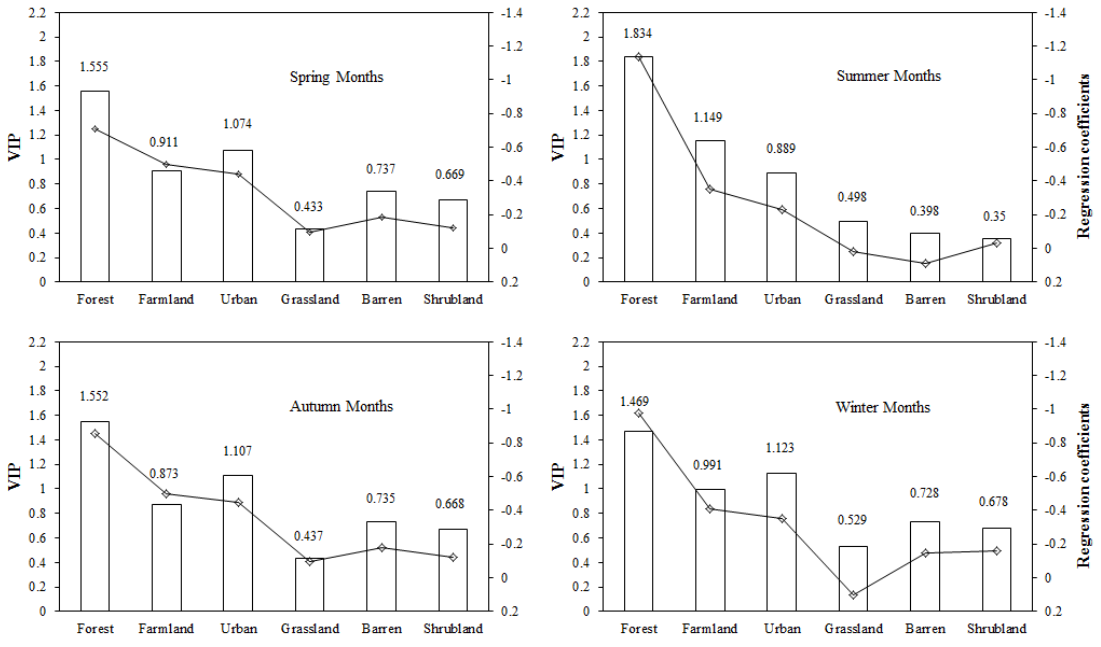
Figure 7. Regression coefficients (lines) and the Variable Influence on Projection (VIP) (bars) of each land use type. Table 6. Summary of partial least-squares (PLS) regression models of baseflow for all sub-watersheds. Response